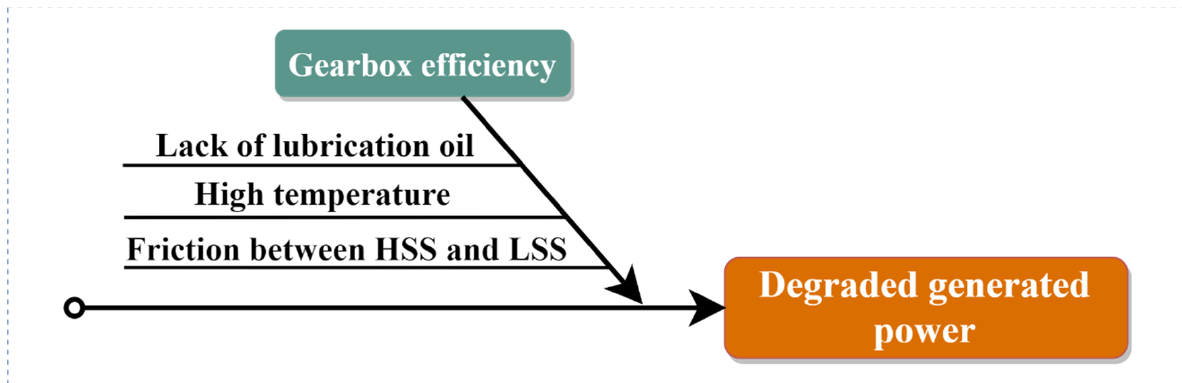
Figure 3. Simplified cause-and-effect diagram of the main problem considered in this